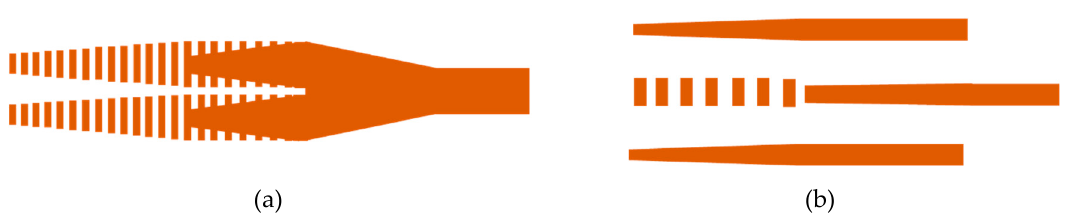
Figure 9. Schematic of ( a ) fork-shape coupler and ( b ) trident coupler assisted with subwavelength gratings structure.